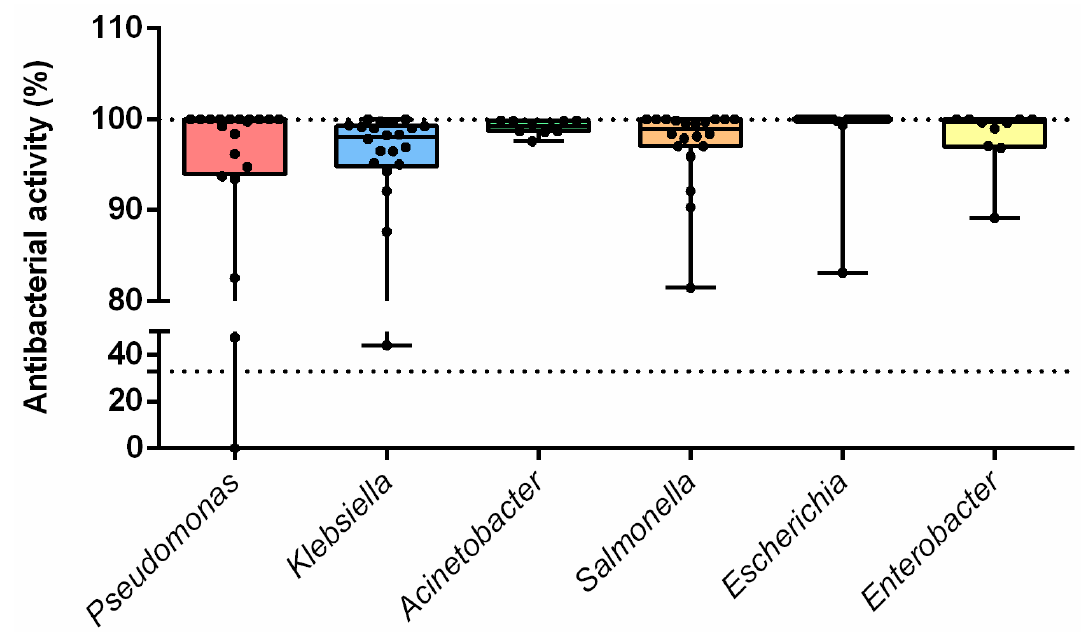
Figure 2. The spectra of antibacterial activity of LysECD7-8his fusion. Lines, medians; boxes, IQR whiskers, min-max. The protein concentration used was 100 µg/mL of LysECD7-8his. The 33% activity cut-off is indicated with a dotted line.